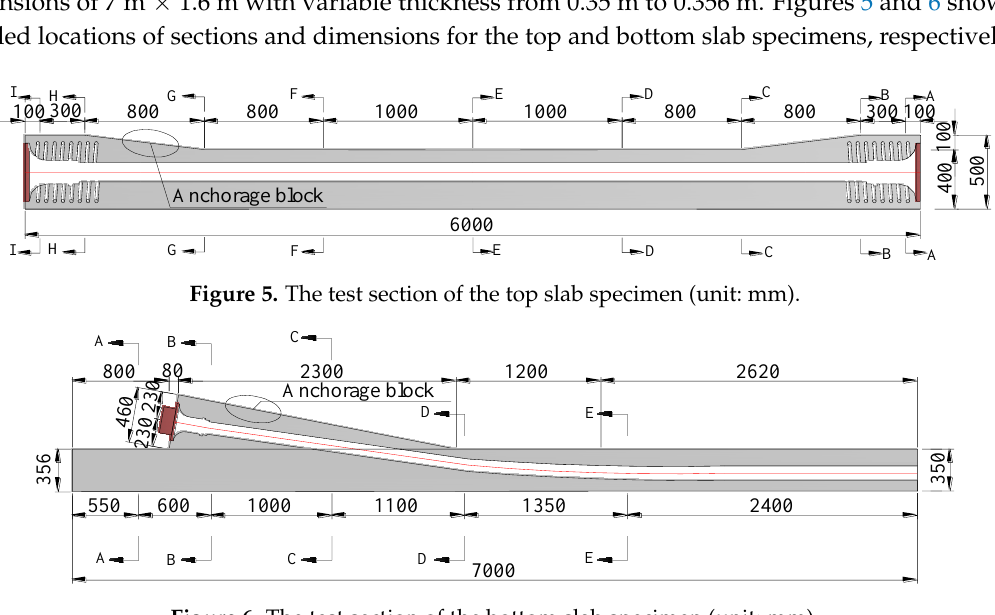
Figure 7. Schematic diagram of reinforcing steel bar under anchor: ( a ) top slab (A-A–B-B); and ( b ) bottom slab (B-B–D-D).